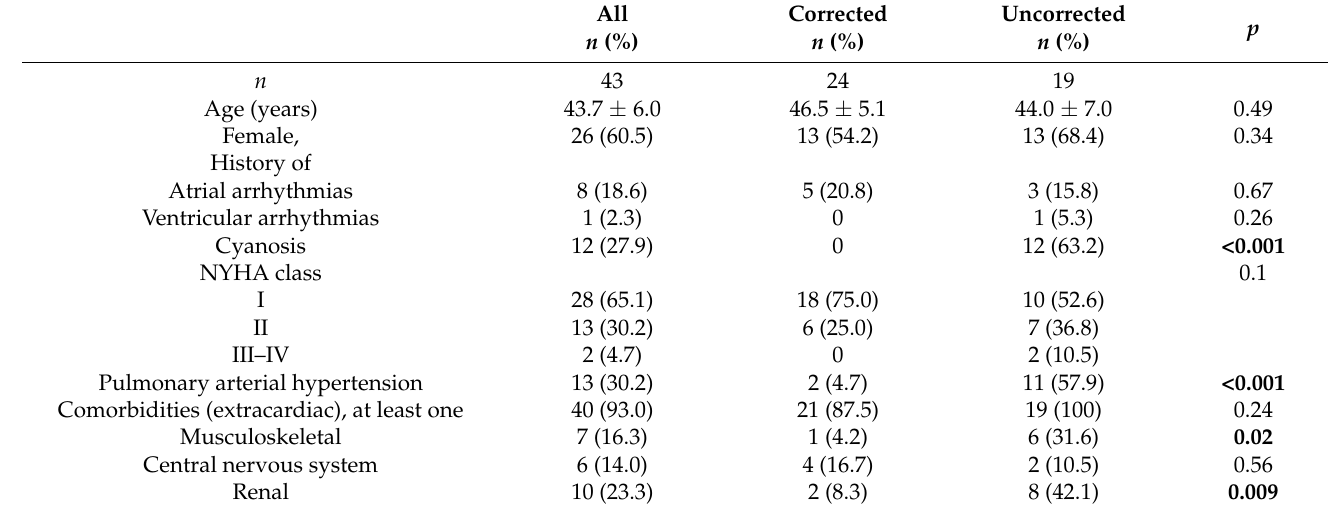
Table 2. Baseline characteristics of patients with corrected vs. uncorrected